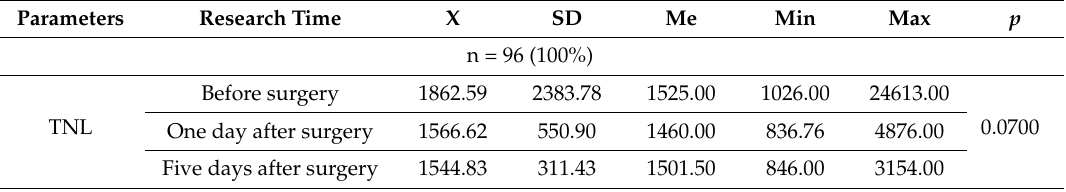
Table 1. Statistical analysis of the nutritional status of patients who underwent CABG based on TNL. Parameters Research